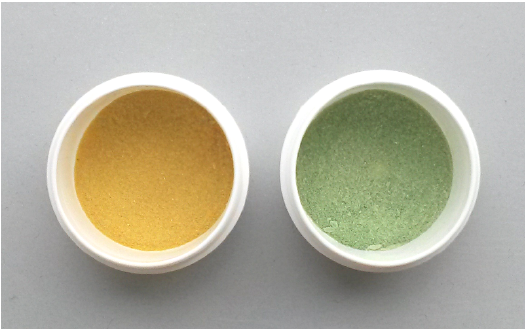
Figure 11. ITO powder sample, before ( left ) and after ( right ) TPD in He, showing a discoloration from yellow to